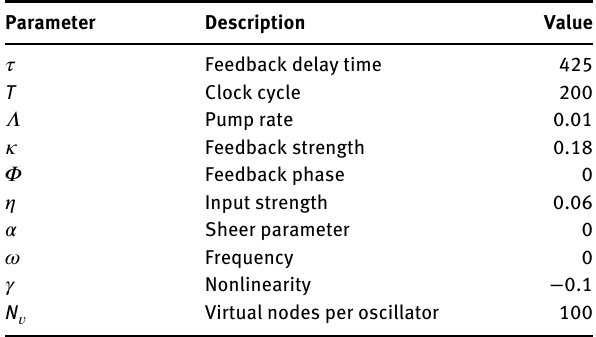
Table 1: Default parameter values for numerical